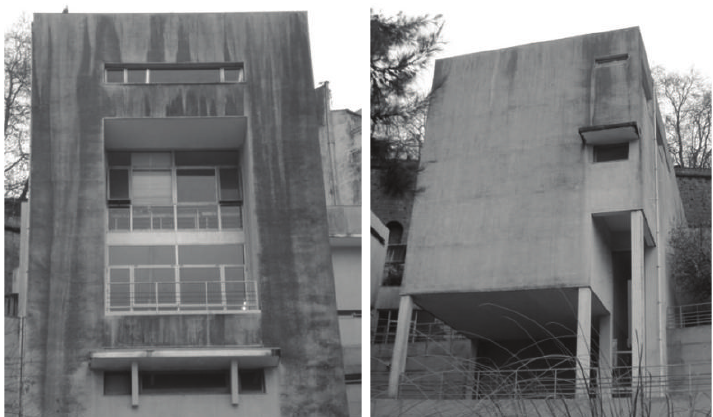
Figure 5: Defacement of ETICS due to biological growth (school building in Porto,